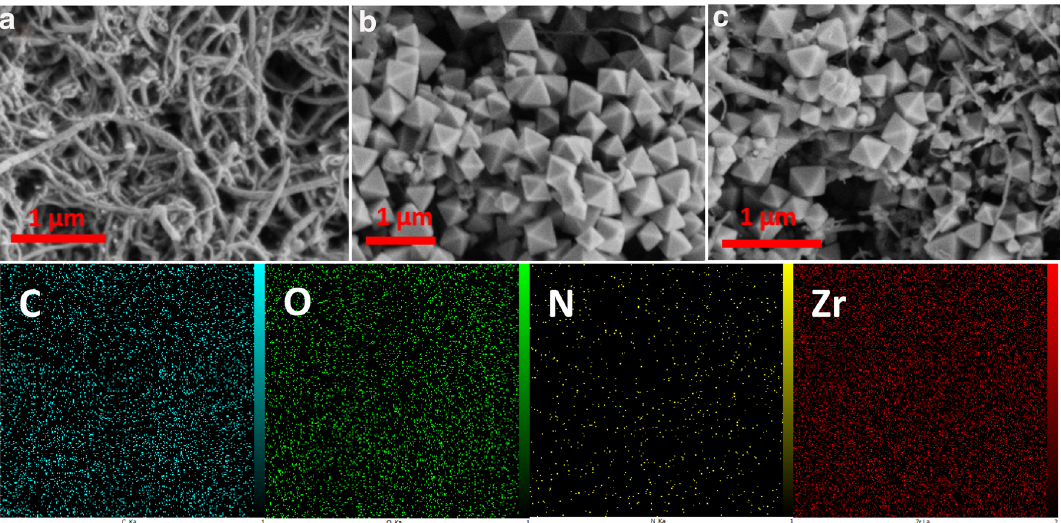
Figure 1. SEM images of ( a ) CNTs, ( b ) UiO-66-NH 2 , ( c ) UiO-66-NH 2 /CNTs, and EDS mapping of hybrid